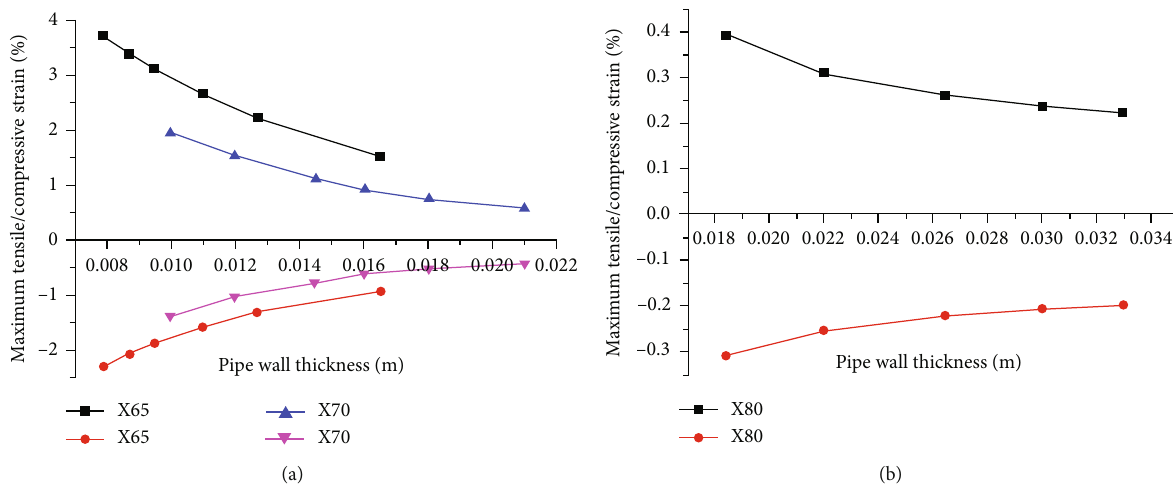
Figure 12: Relationship between maximum tensile and compressive strains and pipe wall thickness: (a) X65 and X70 steel grade and (b) X80 steel grade.